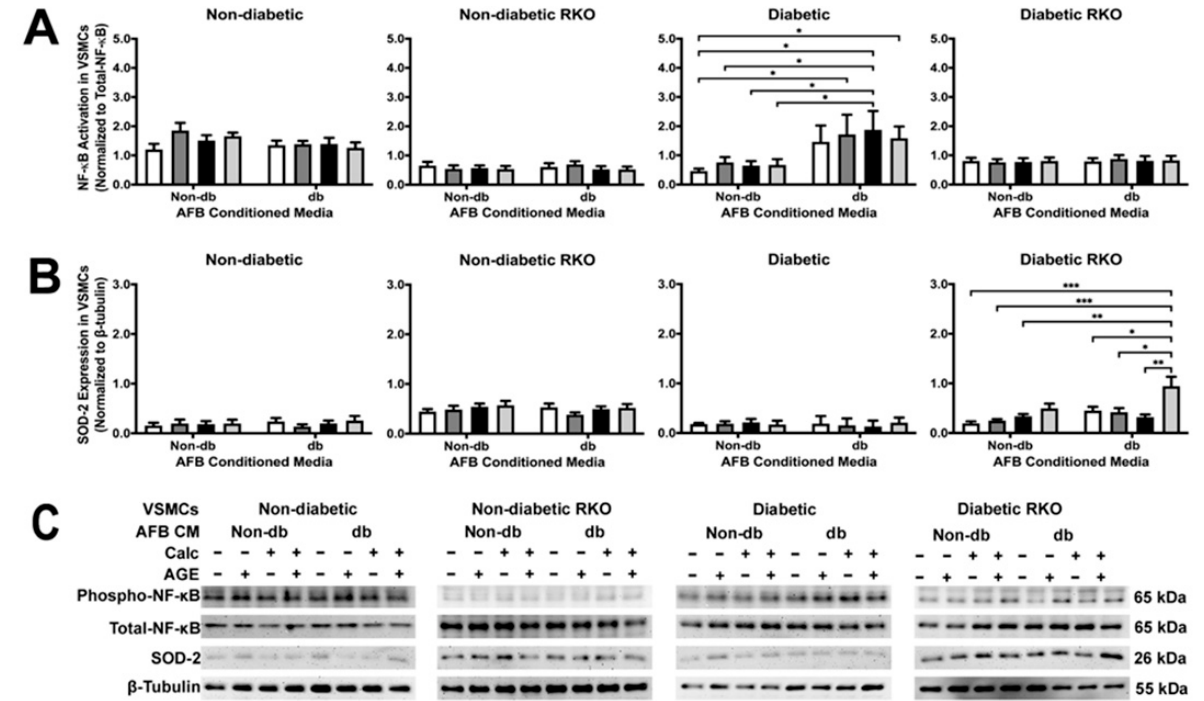
Figure 4. Diabetic AFBs-conditioned media increased N κ B activation in diabetic VSMCs and in- creased SOD-2 expression in diabetic RKO VSMCs. Primary VSMCs were isolated and treated with AFBs-conditioned media at a 1:10 dilution in 2% FBS genotype appropriate DMEM for 7 days. Protein expression was quantified of p65 NF- κ B (65 kDa: ( A )) and SOD-2 (26 kDa: ( B )). All protein levels were normalized to β -tubulin ( C ) and graphed as mean ± SEM with n = 3–6 of independent replicates. A two-way ANOVA with Fisher’s LSD post hoc was performed (* p < 0.05, ** p < 0.01, *** p < 0.001) on each graph individually. All data were analyzed together with a two-way ANOVA to give the following: NF- κ B (Interaction; p = 0.0019, Genotype; p < 0.0001, and Treatment; p = 0.0267) and SOD-2 (Interaction; p = 0.0648, Genotype; p < 0.0001, and Treatment; p = 0.0343).